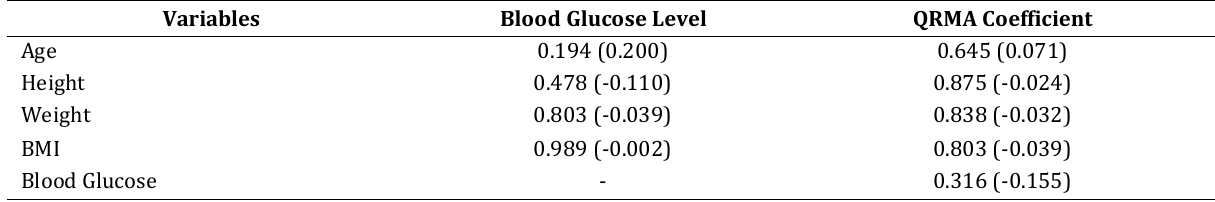
Table 3. Correlation between Age, Height, Weight and BMI with Blood Glucose and the QRMA Coefficient, 2017 (n = 44)